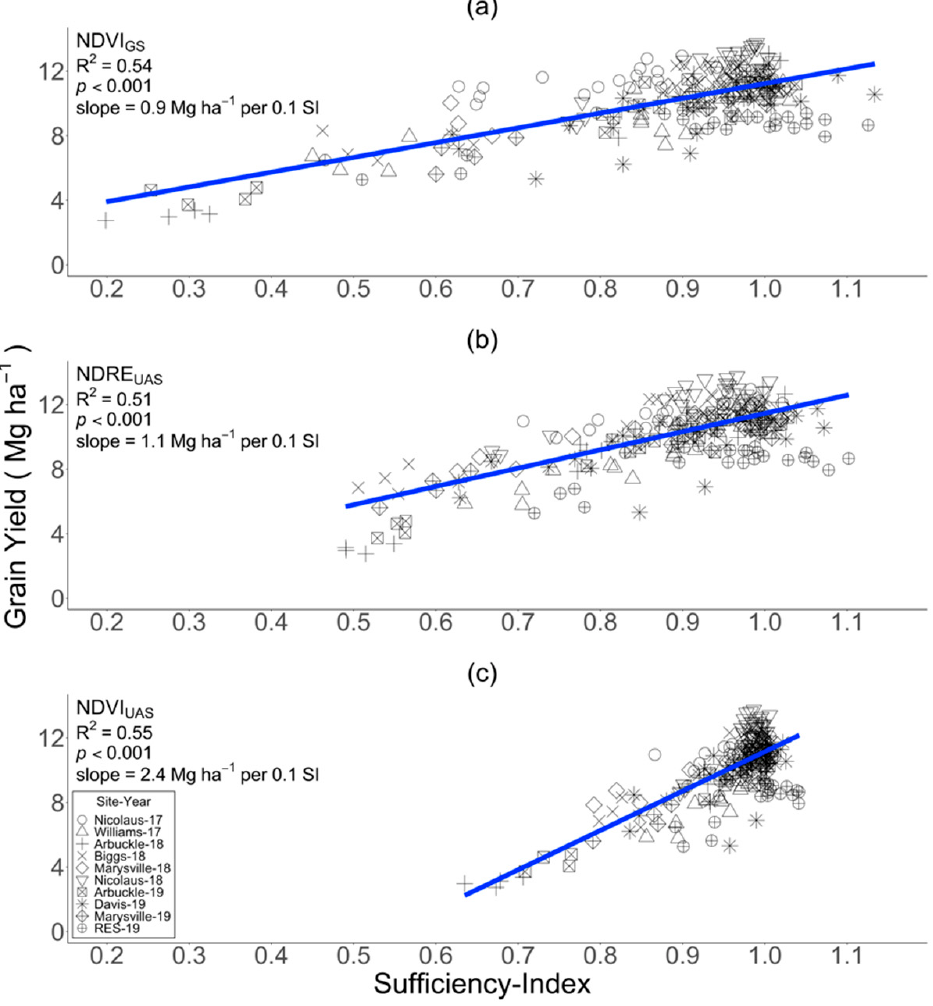
Figure 7. The relationship between ( a ) GreenSeeker Normalized Difference Vegetation Index (NDVI GS) Sufficiency-Index (SI), ( b ) unmanned aircraft system (UAS) Normalized Difference Red-Edge Index (NDRE UAS ) SI, and ( c ) NDVI UAS SI measured at panicle initiation (PI) rice growth stage and grain yield as described by linear mixed-effects models. The coefficient of determination (R 2 ) reported in each panel represents the proportion of variability explained by the model fixed effects